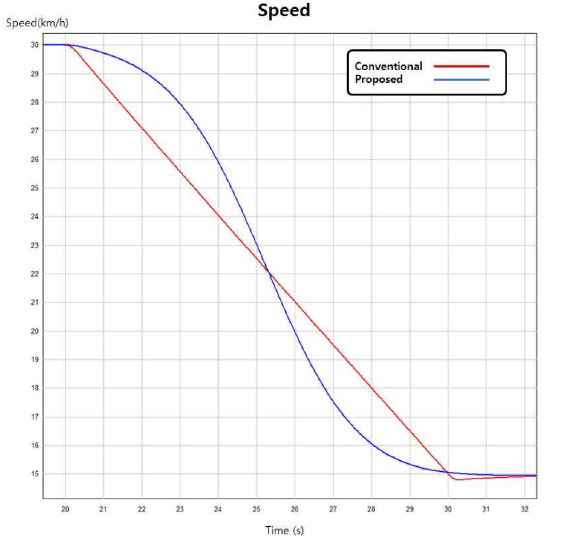
Figure 19. Speed comparison of conventional braking and proposed method when changing speed from 30 to 15 km/h. Both control methods reached 15 km/h within 10 s.